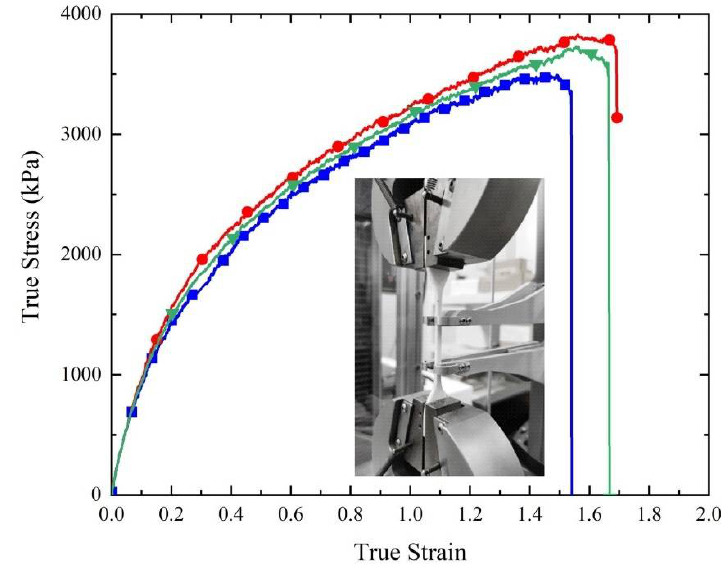
Figure 2. Stress–strain curves of three TPU tensile specimens.